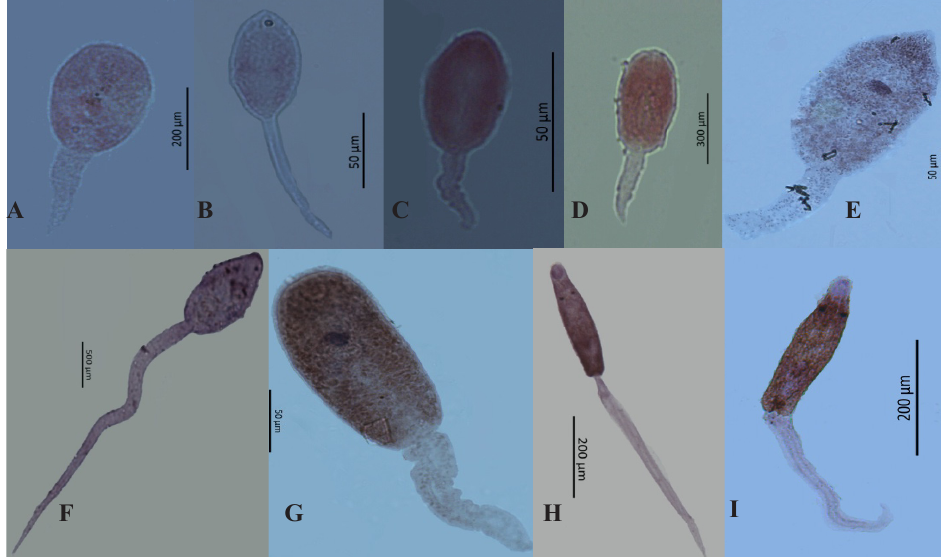
Figure 4: Types of cercariae found in the freshwater snail, Melanoides sp collected from sandy bottoms of Maha-Oya in Kegalle district A) Gymnocephalous type 1, B) Distome, C) Gymnocephalous type 2, D) Gymnocephalous type 3, E) Xiphidiocercous type 1,